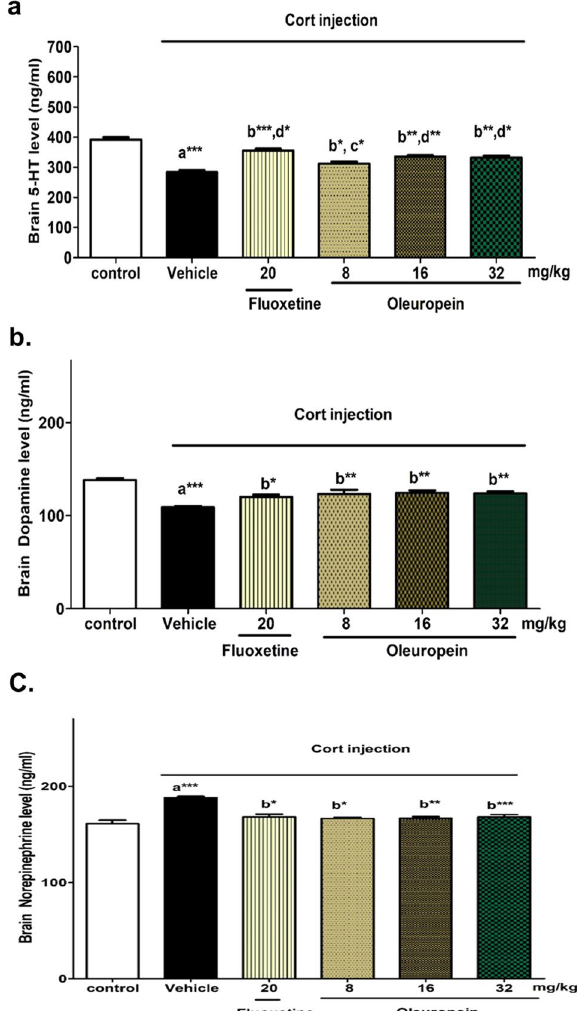
Figure 4. Effects of different doses of oleuropein on brain neurotransmitters’ level in chronic Cort-induced depression model in mice. ( a ) Brain Serotonin (5-HT) Level (ng/ml), ( b ) Brain Dopamine Level (ng/ml), and ( c ) Brain Norepinephrine Level (ng/ml) in different animal groups. Each bar represents the mean of 6 rats + SEM. a: significant compared to the control group; b: significant compared to the Cort group; c: significant compared to Cort + Fluoxetine group; d: significant compared to Cort + oleuropein (8 mg/kg) group. * p ≤ 0.05, ** p ≤ 0.01, *** p ≤